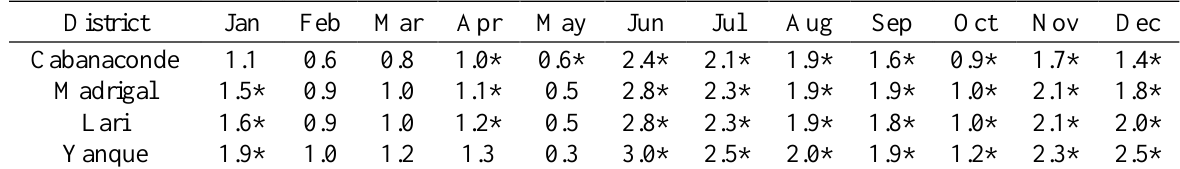
Table A 1 .3. Trends in Monthly Average Maximum Daily Air Temperature (°C) over the Period of 1988 to 2017 for the Different Districts District Jan